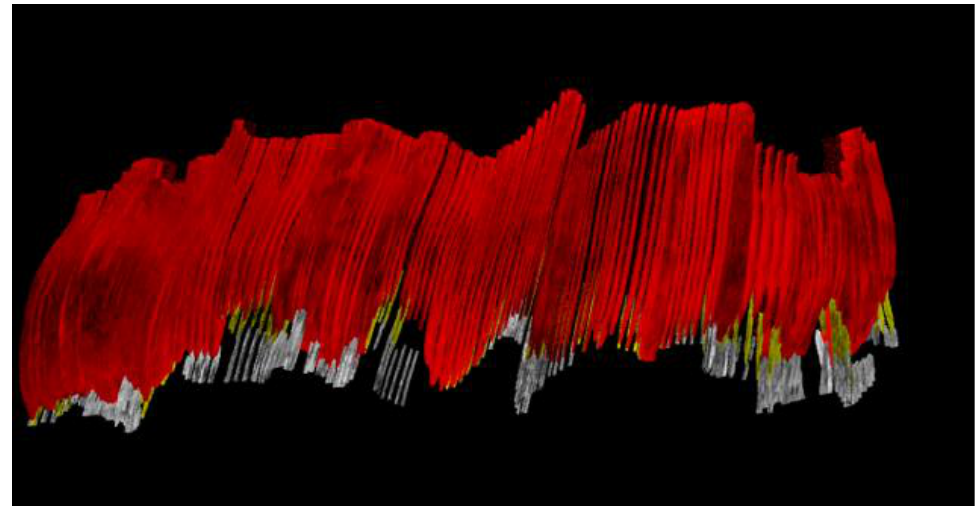
Figure 4. Three-dimensional reconstruction of maxillary arch, marginal periodontal tissue, buccal surface of the gingiva — red, crown surface — white, root surface — yellow. One can easily see areas where the gingival contour and margin is unregulated, showing artifacts or errors in masking the periodontal anatomical elements.